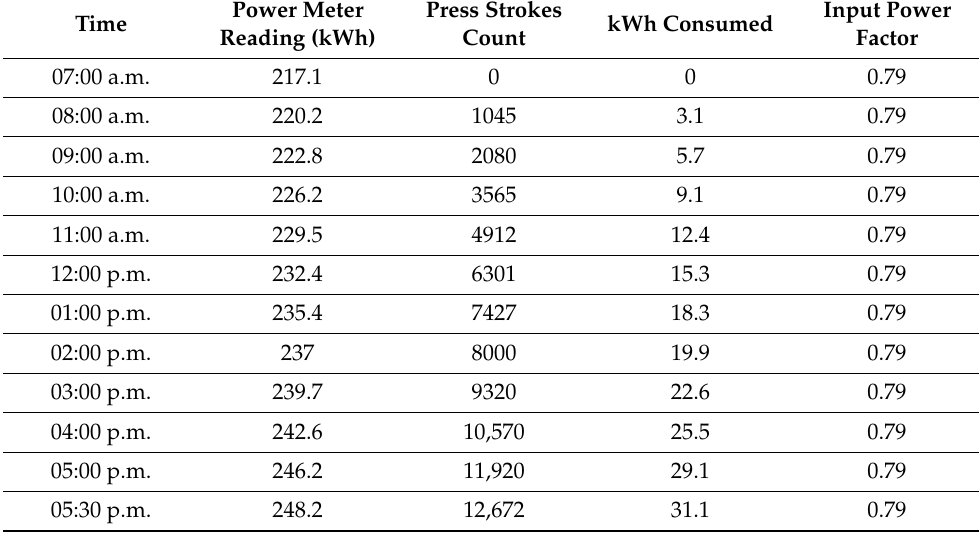
Table 3. Data collection was accomplished using an IIoT-based monitoring system with DOL